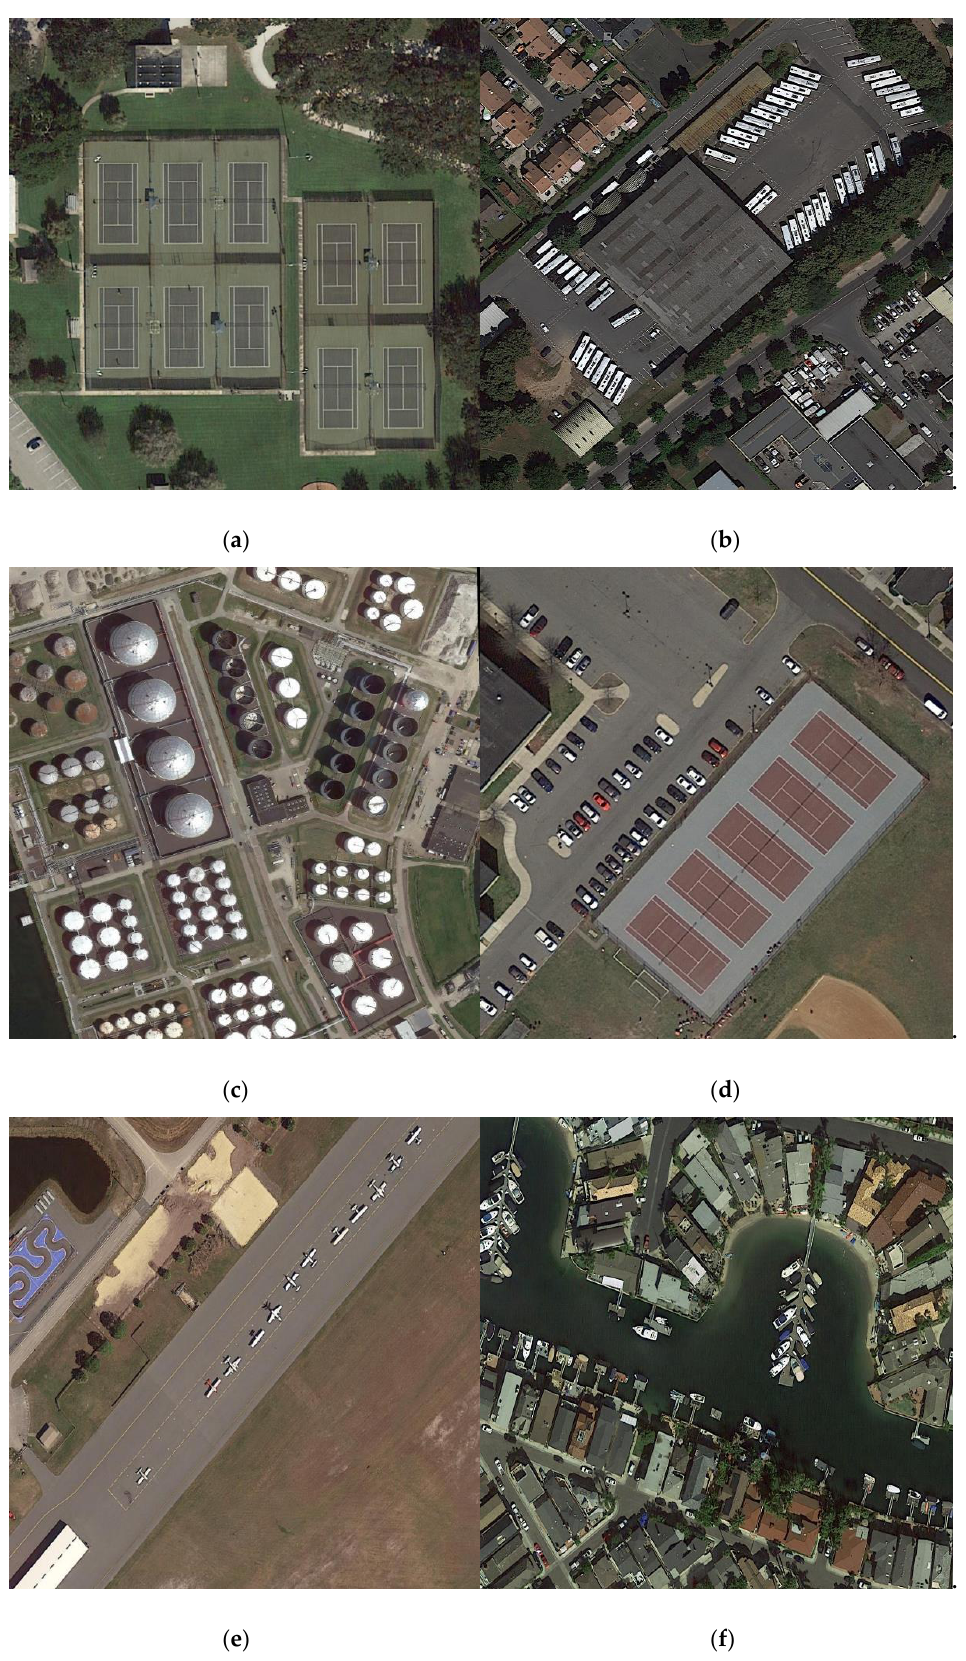
Figure 13. Some images in the validation set of the dataset for object detection in aerial images